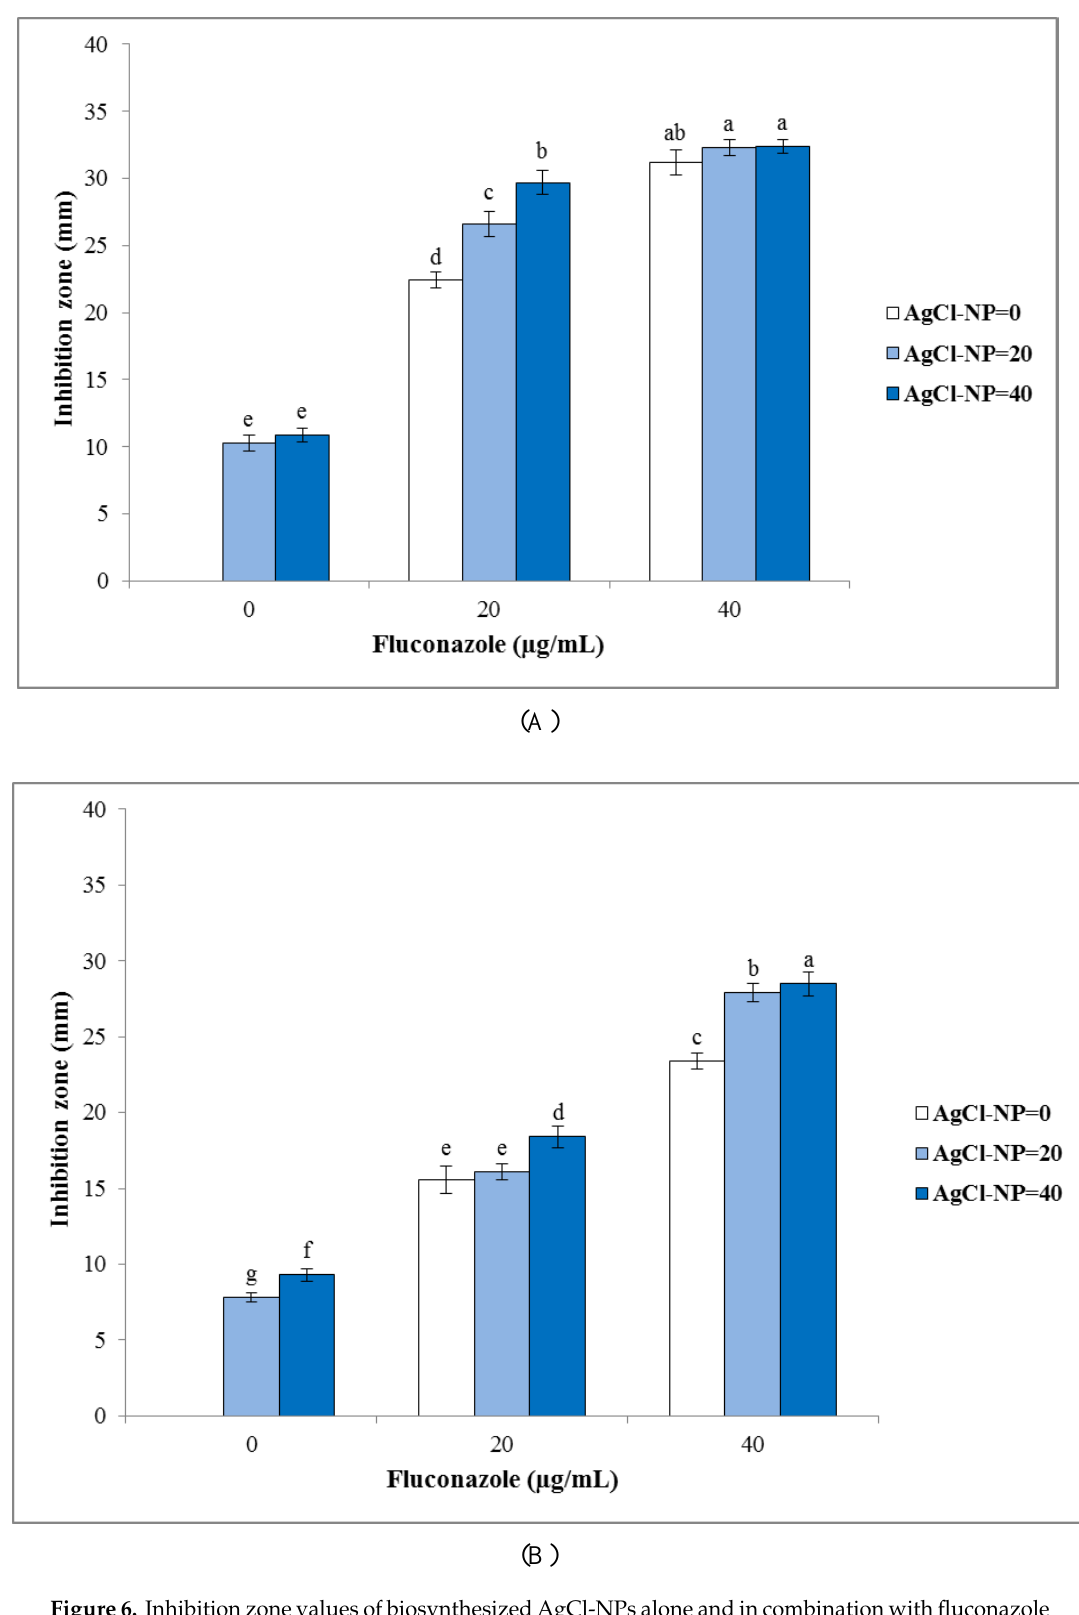
Figure 6. Inhibition zone values of biosynthesized AgCl-NPs alone and in combination with fluconazole against tested fungi strains. ( A ) Candida glabrata ; ( B ) C. albicans . Different letters indicate significant differences ( P < 0.05) among various treatments.